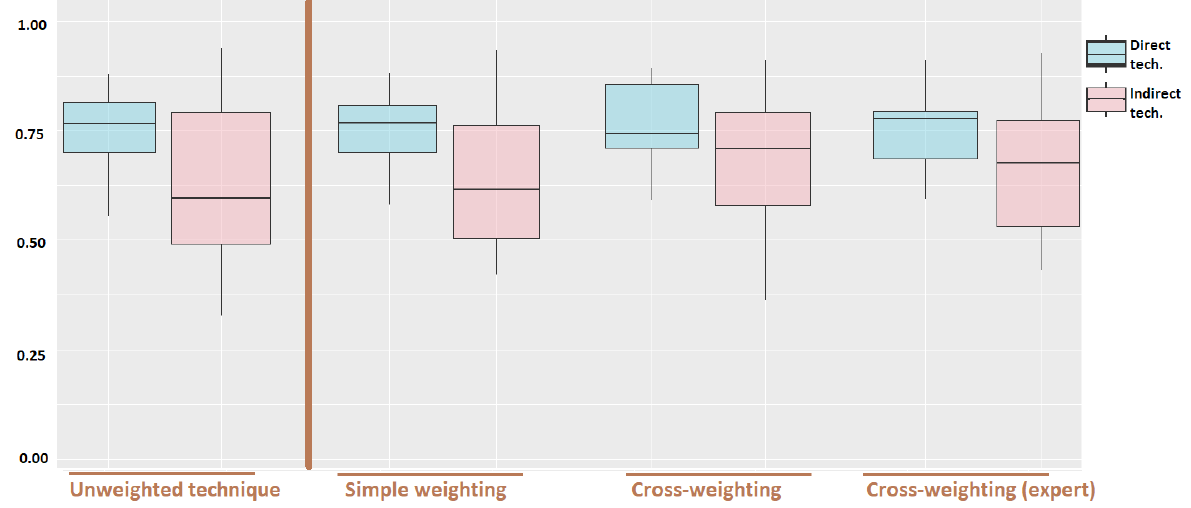
Figure 10. Usability scores results distribution—between desktop subjects